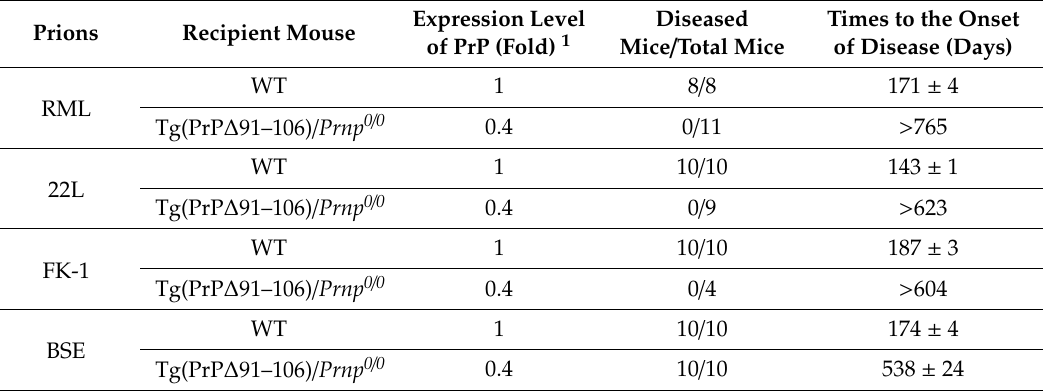
Table 1. Incubation times in WT and Tg(PrP ∆ 91–106) / Prnp 0 / 0 mice inoculated with RML, 22L, FK-1 and bovine spongiform encephalopathy (BSE)